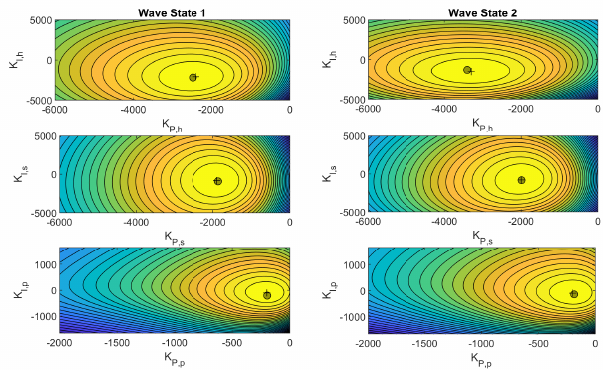
Fig. 7: The WEC power surface as a function of gain tuning for each degree of freedom and wave state for the CDIP 225 wave. Optimal absorbed power is the brightest